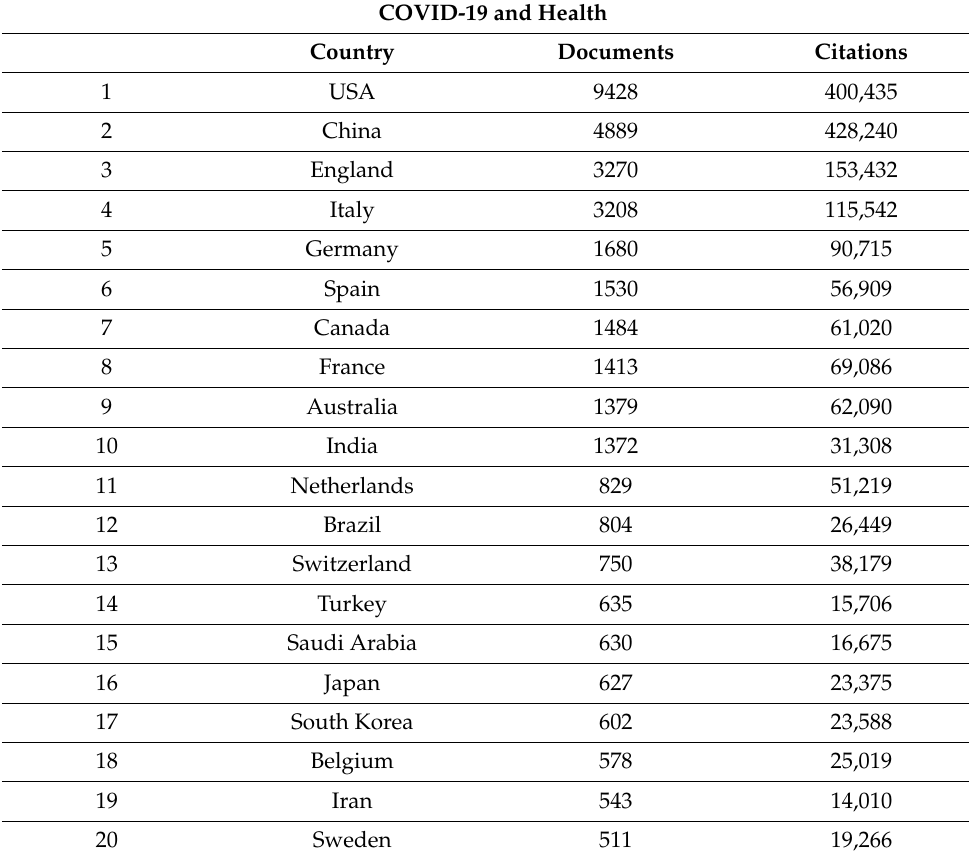
Figure 1. Countries with the highest scientific output on COVID-19. Table 6. Countries, number of articles and citations on COVID-19 and